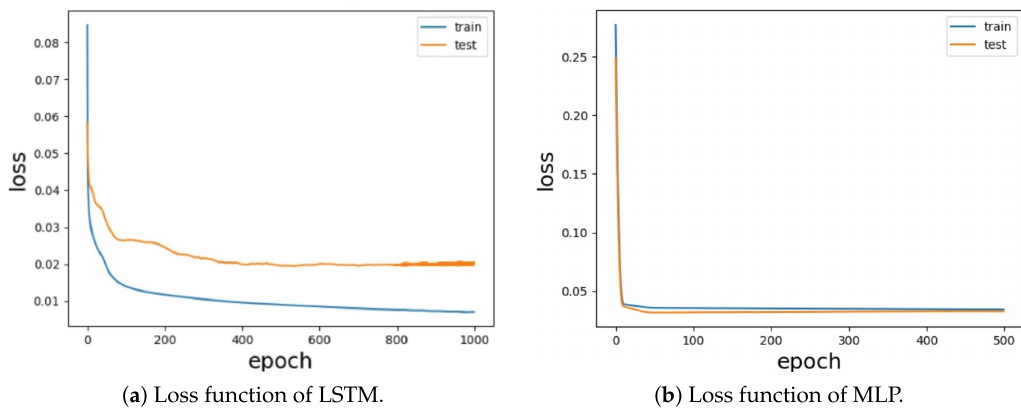
Figure 8. Loss function for load power forecast with summer data.